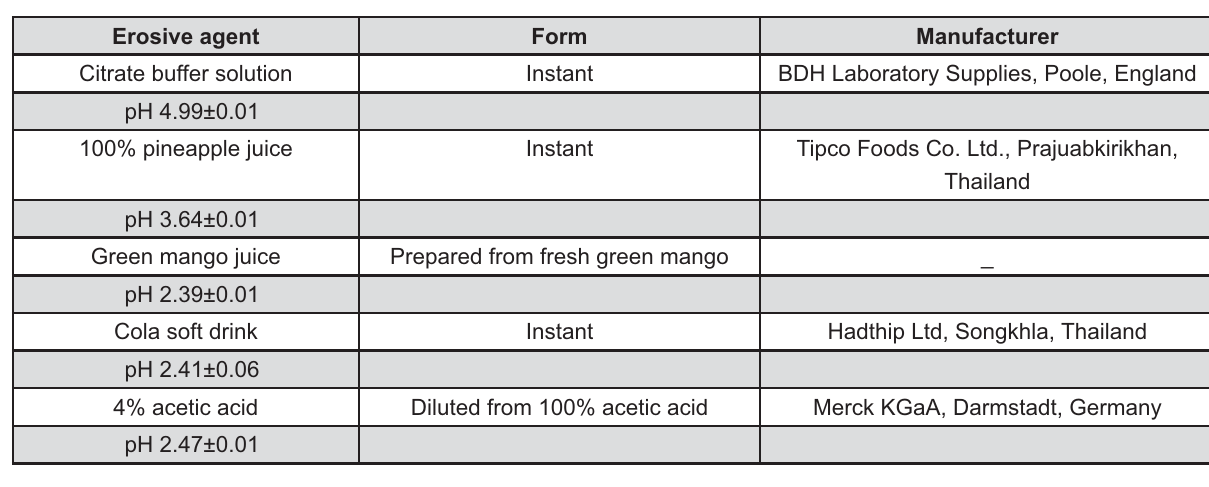
Figure 2- Erosive agents used in the present study